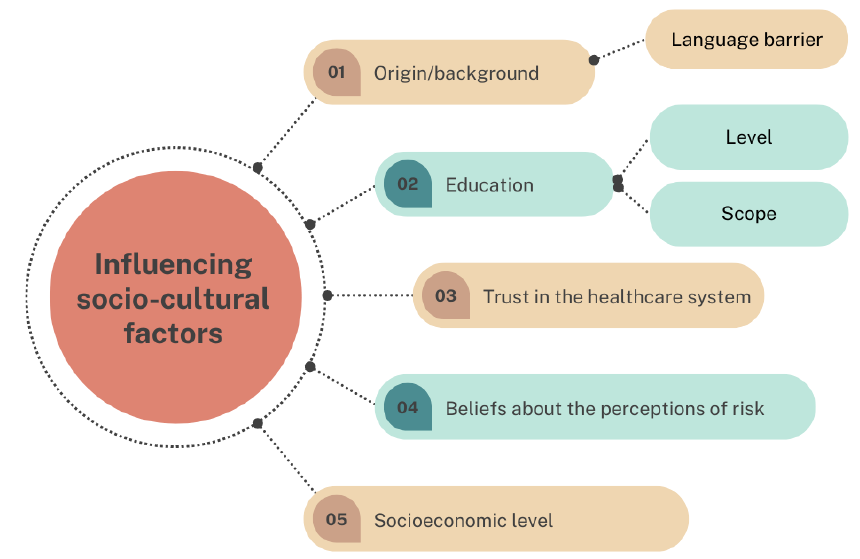
Figure 1. Socio-cultural factors influencing vaccination uptake during pregnancy.